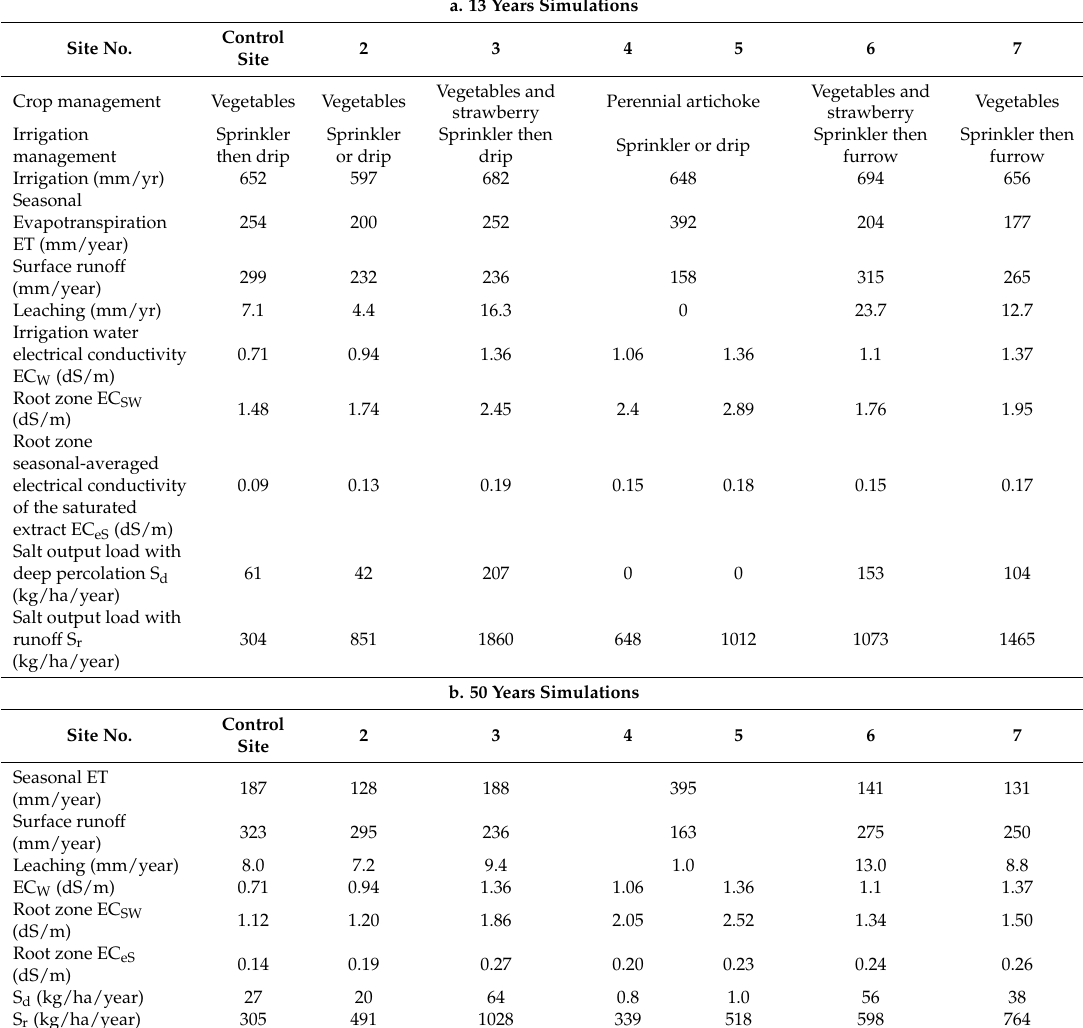
Table 9. Summary of annual average water balance and salinity variables for the different field management